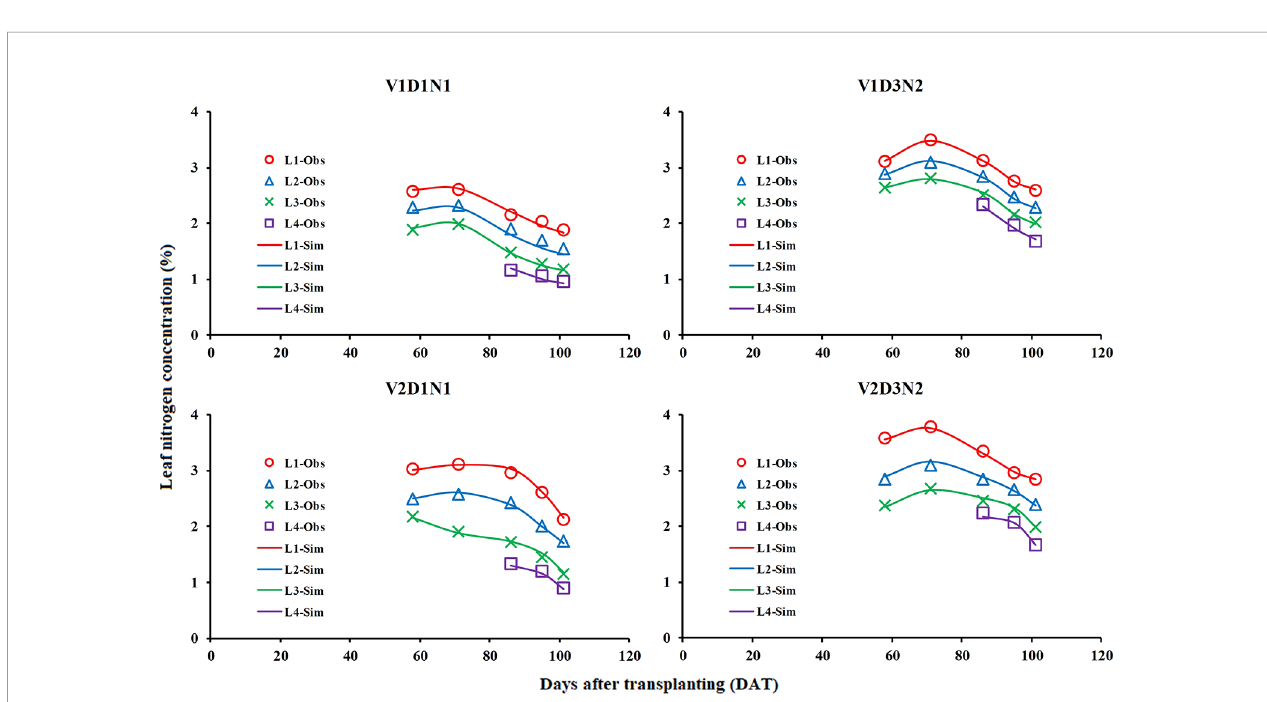
FIGURE 8 | Comparison of simulated (Sim) and observed (Obs) distribution of leaf nitrogen concentration in rice canopy (take V1D1N1, V1D3N2, V2D1N1, and V2D3N2 for